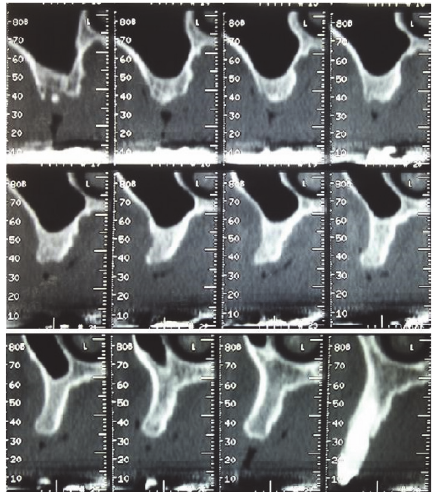
Figure5:Initialcase,TCDentascan,cross-sectionalimagesperpen- dicular to alveolar process of the maxilla.